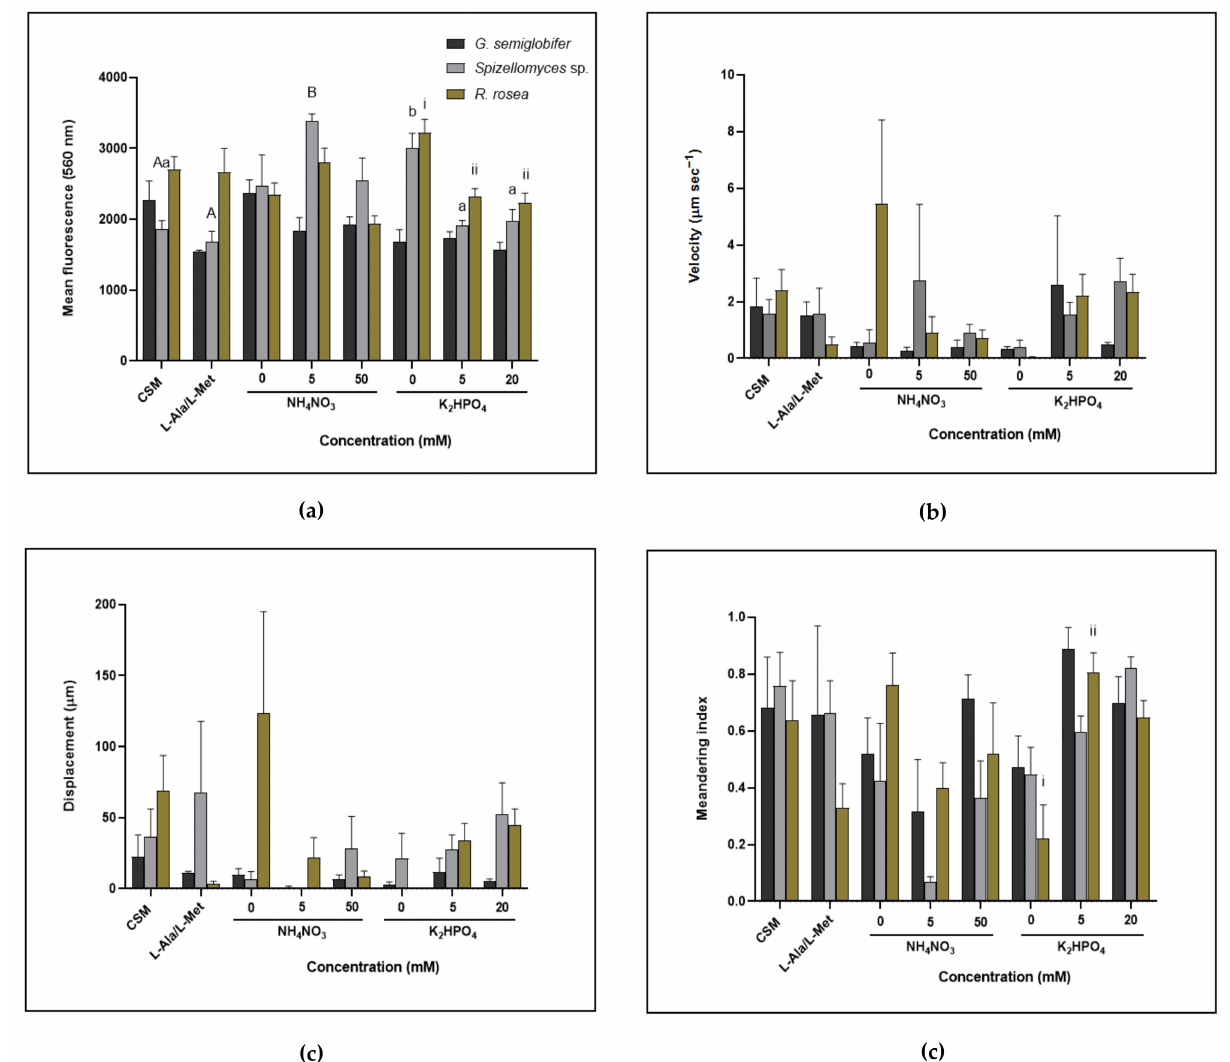
Figure 4. Microscopic analysis of chytrid zoospores at 8 weeks. ( a ) Mean fluorescence of lipid- stained zoospores. Significant differences were found when nitrogen treatments were compared (F 4, 57 = 4.047, p < 0.05) and the phosphate treatments (F 3, 51 = 12.52, p < 0.05) ( b ) Zoospore velocity ( µ m s − 1 ). No significant differences were observed in the nitrogen (F 4, 56 = 0.719, p > 0.05) or phosphate series (F 3, 50 = 2.841, p > 0.05) ( c ) Displacement ( µ m) of zoospores. No significant